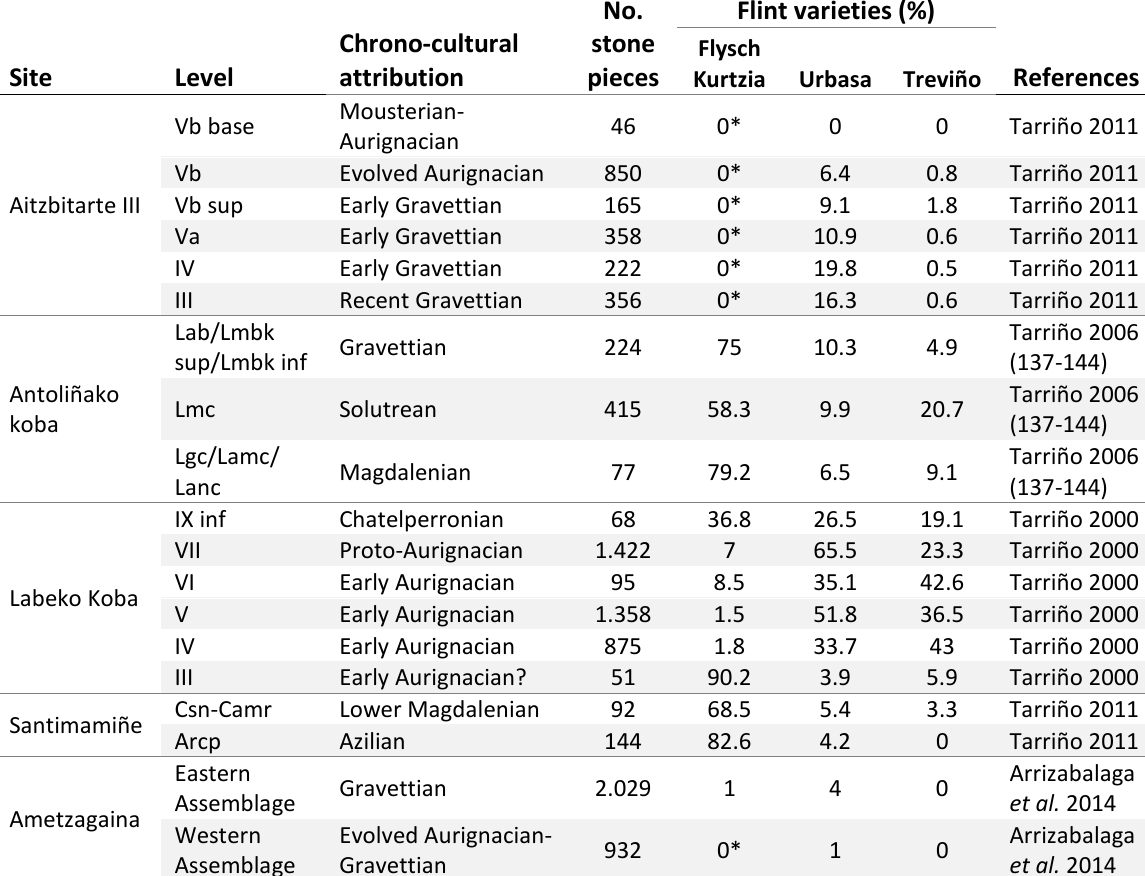
Table 1. Raw data of the sites and the archaeological levels included in the study. An asterisk indicates the identification is only probable, since it was not easy to distinguish the Flysch variety of Kurtzia from the other Flysch varieties available in the region. Only cases where the Flysch flint identification is specified in the bibliography are